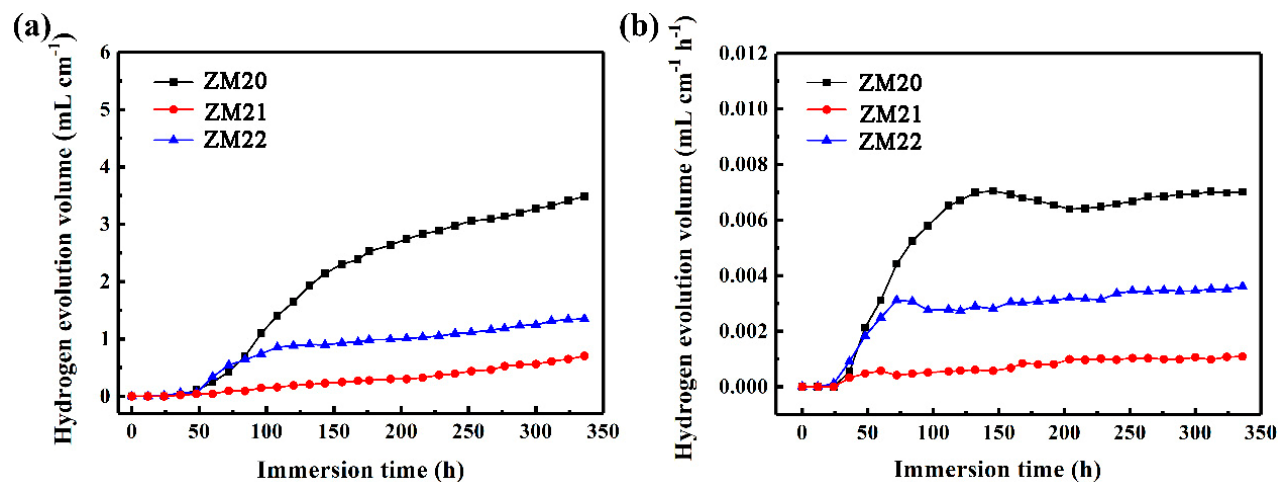
Figure 8. Hydrogen evolution ( a ) volume and ( b ) rate of different samples in 3.5 wt.% NaCl solution.